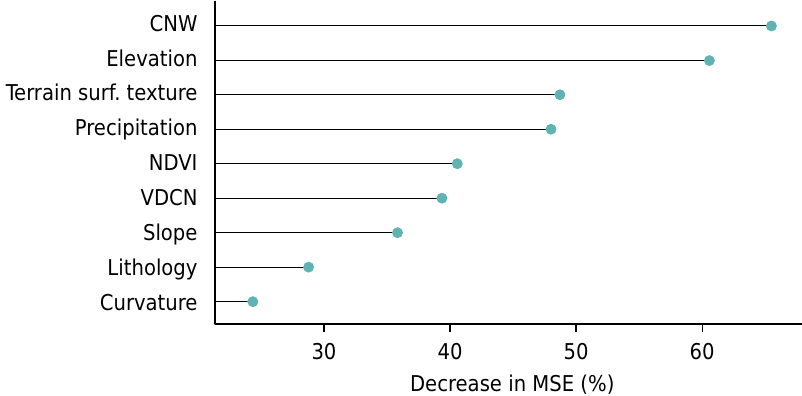
Figure 5. Importance of the covariates for soil mapping using Random Forest